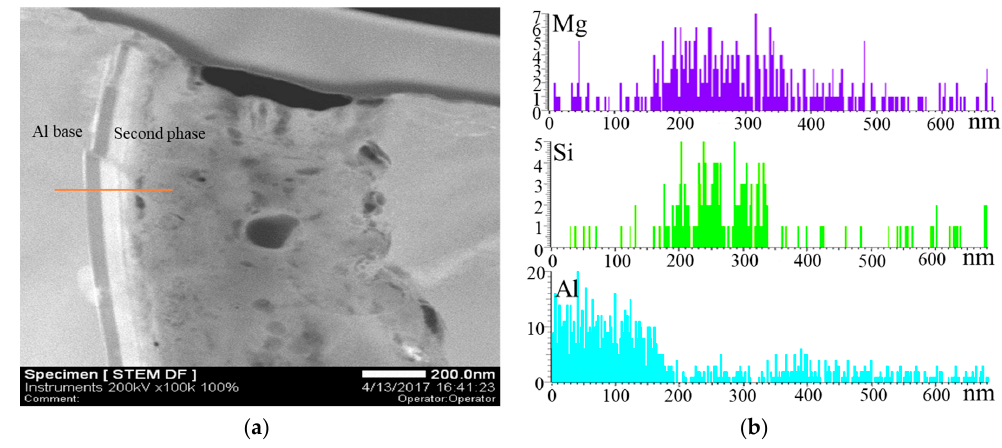
Figure 9. ( a ) TEM image; ( b ) TEM-EDS line scanning profile of the interface between Al matrix and second phase after 24 h homogenization at 450 °C.